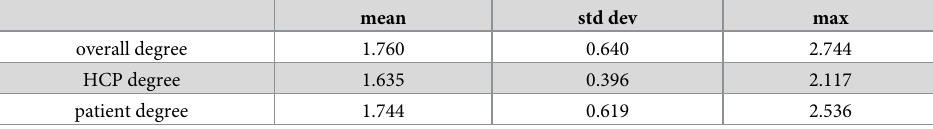
Table 3. Network statistics of temporal graph G d , t . The statistics shown here are obtained by averaging over all (approximately) 177K temporal graphs (177K � 26 days × 6822 timesteps per day). mean std dev max overall degree 1.760 0.640 HCP